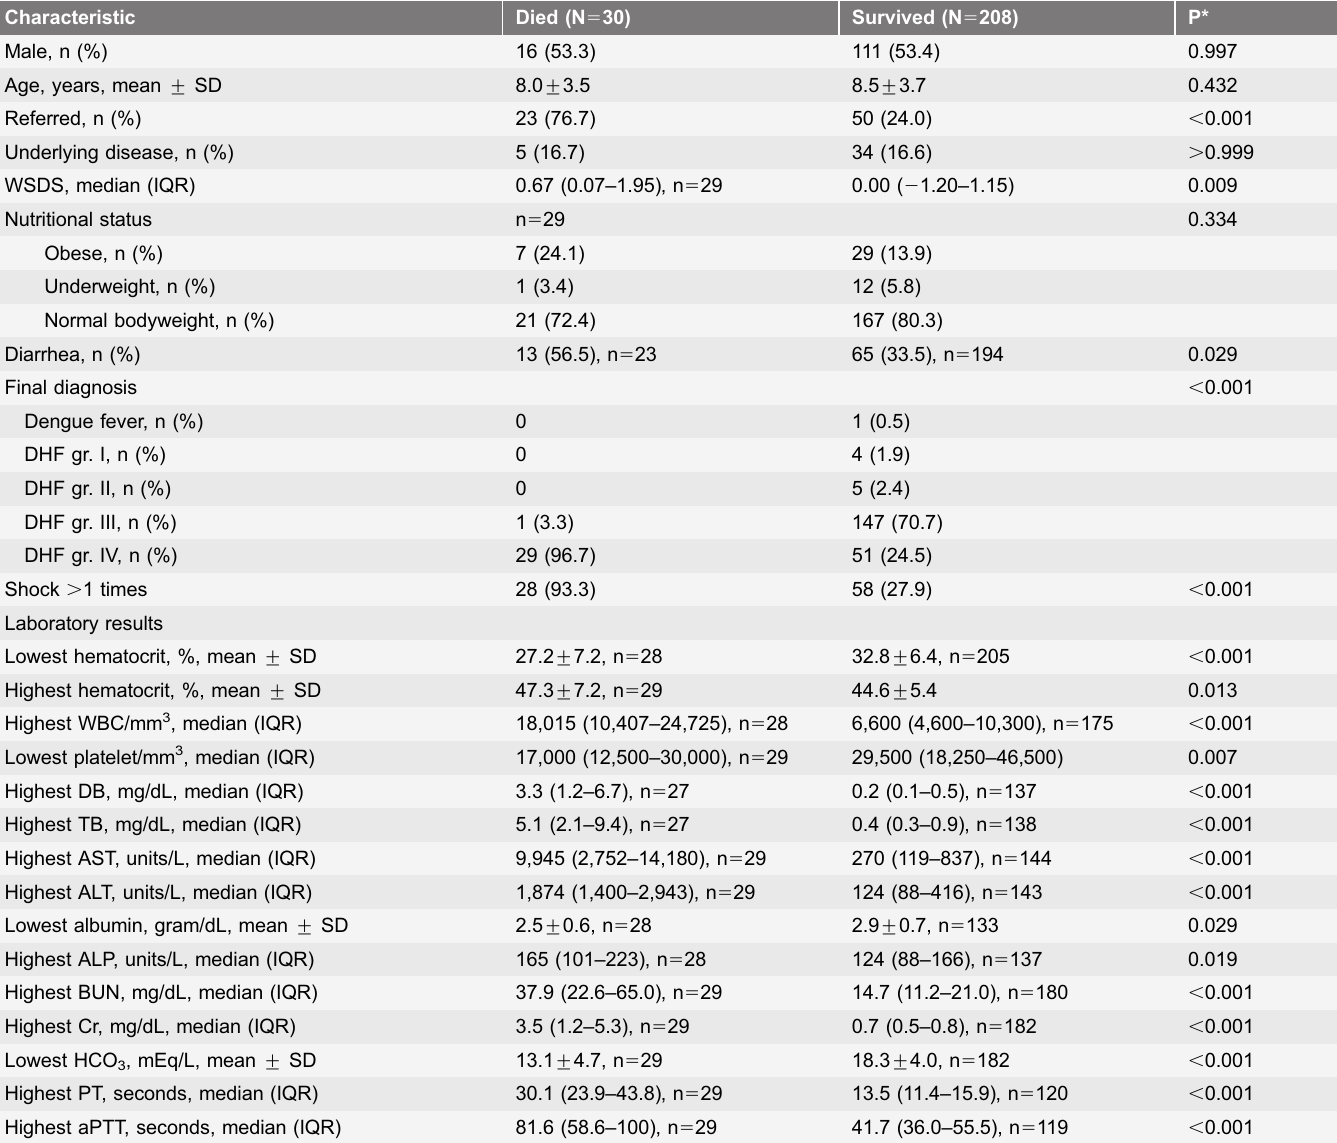
Table 1. Comparing characteristics and laboratory results of patients with severe DVI between those who died and those who